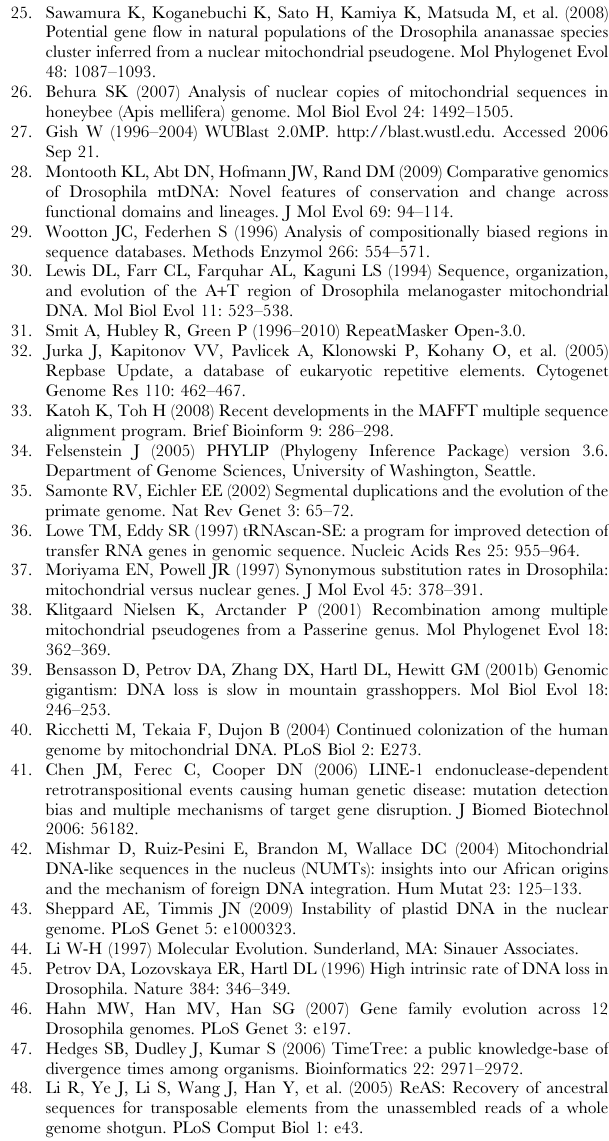
Table S3 List of orthologous numts between species. Each row represents an ortholog set, and each cell is an individual numt or a group of paralogous